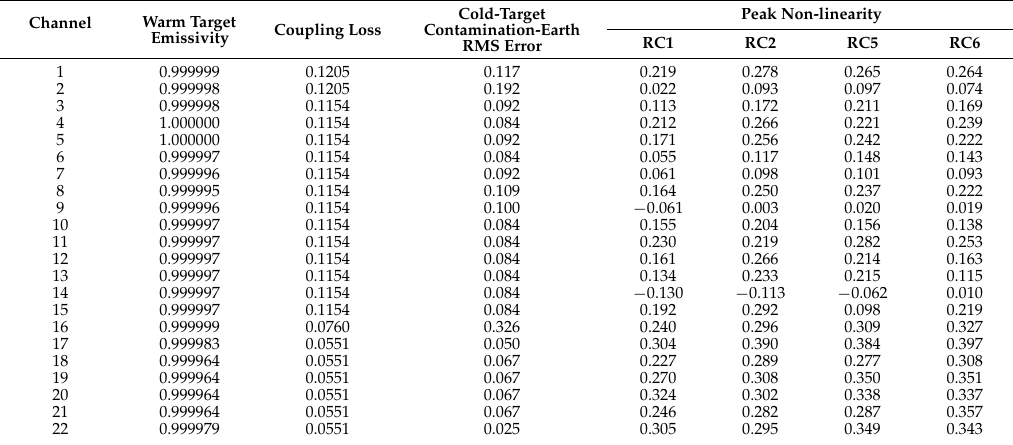
Table 2. SNPP ATMS Prototype Flight Model test data used for error budget studies.